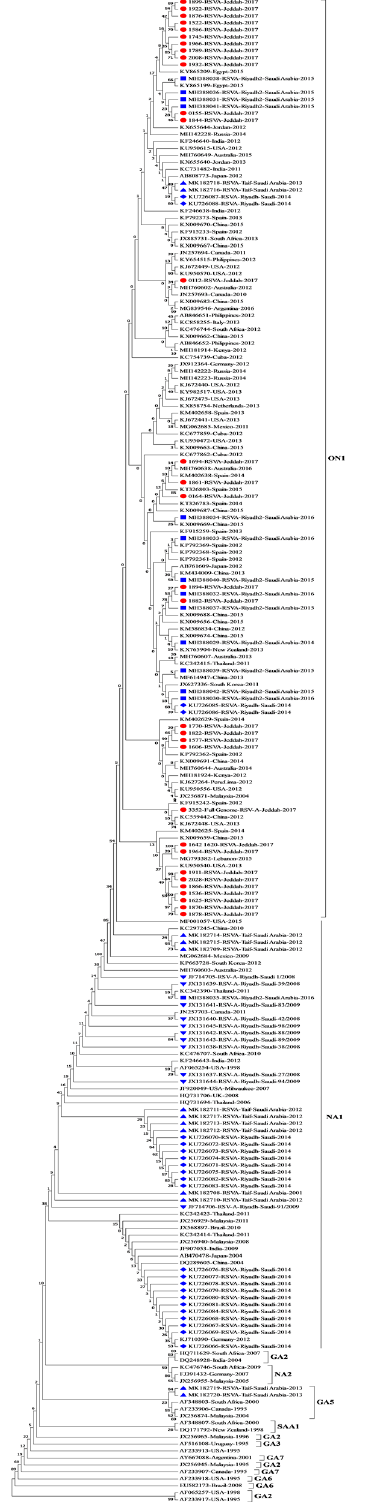
Figure 2. Phylogenetic analysis of G-gene of RSV group A in Jeddah, Saudi Arabia (2017). Saudi sequences in this study are labeled with a red square and reference strains are labeled as accession number-country-year of isolation; Saudi reference strains isolated in 2014 are labeled with a blue diamond and those isolated in 2014–2016 are labeled with a blue circle; the Riyadh samples isolated in 2008–2009 are labeled with an inverted triangle and Taif samples are labelled with a blue triangle Phylogenetic trees were constructed using the neighbor-joining method after being aligned with CLUSTALW using MEGA 7.